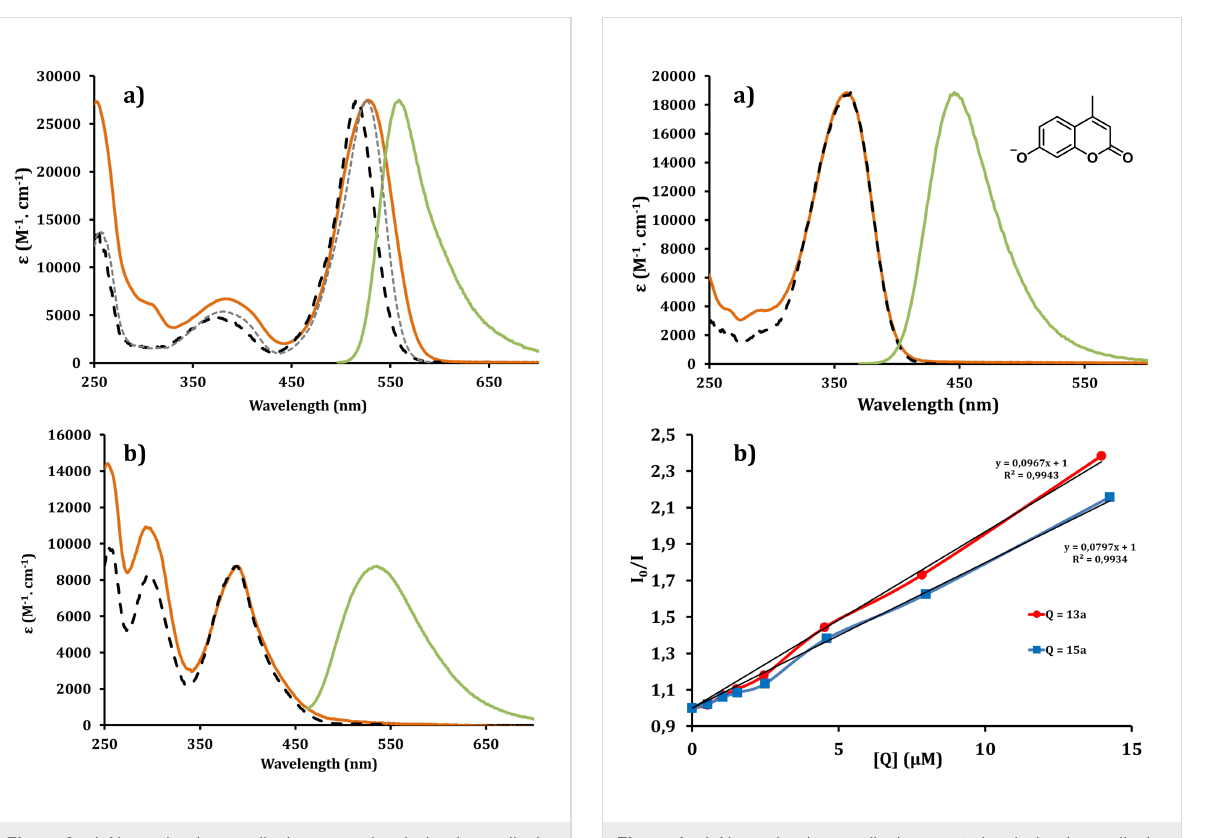
Figure 3: a) Absorption (orange line), corrected emission (green line) ( λ exc = 510 nm), excitation (dashed black line) ( λ em = 630 nm) and excitation with 2.5% of SDS (small dashed grey line) spectra for 13a ; b) Absorption (orange line), corrected emission (green line) ( λ exc = 390 nm) and excitation (dashed black line) ( λ em = 550 nm) spectra for 15a ; in glycine buffer at pH 10.7 at rt.